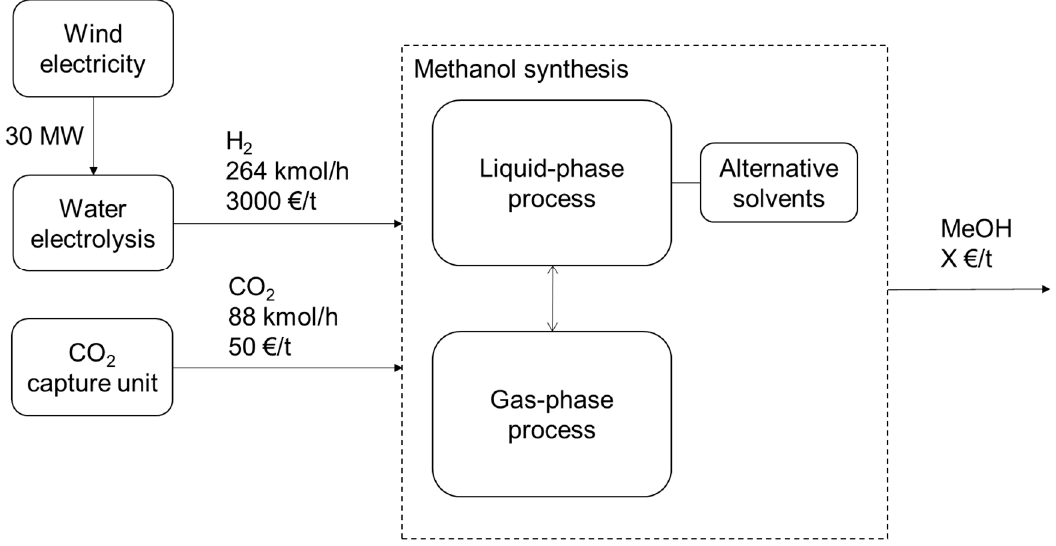
Figure 1. Scope and boundaries of the techno-economic analysis of CO 2 hydrogenation to methanol and the plant design capacity based on renewable electricity